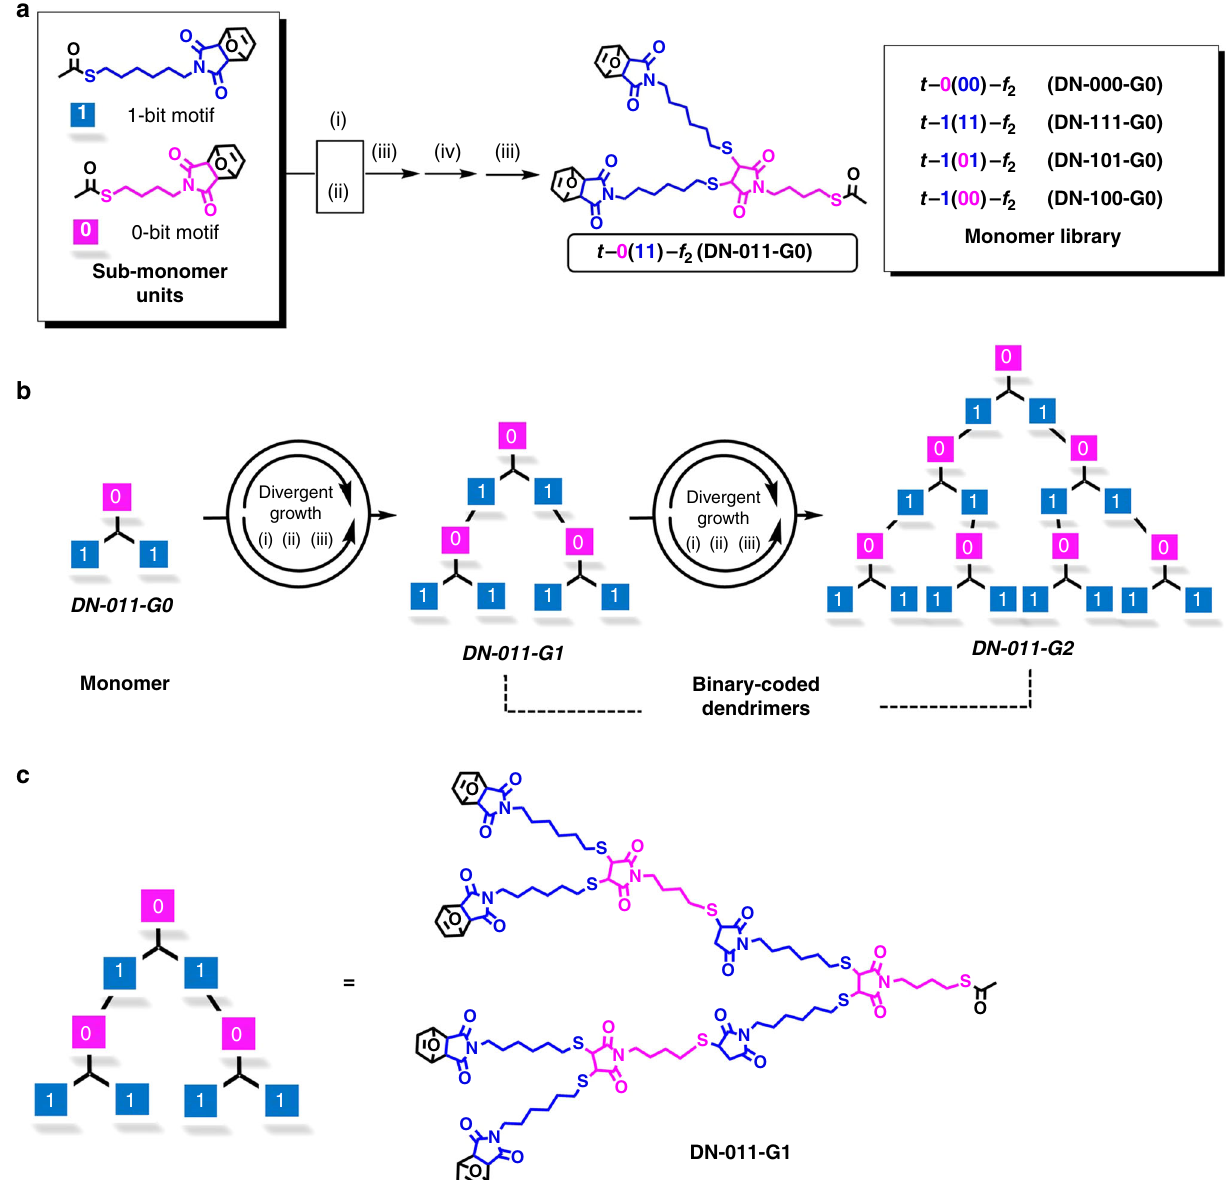
Fig. 2 Synthesis of binary-coded digital dendrimers. a Synthesis of the monomers from the binary sub-monomer units (0- and 1-bit) based on orthogonal deprotections of thiol and maleimide (i and ii), thiol-maleimide Michael addition (iii) and maleimide ring regeneration maleimide ring (iv). b Construction of binary-coded dendrimers from monomers via divergent growth strategy (i, ii, and iii). Experimental conditions: (i) con. HCl, MeOH, 70 °C or